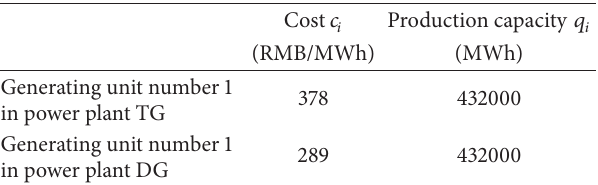
Table 1: The cost and production capacity of two competitive generating